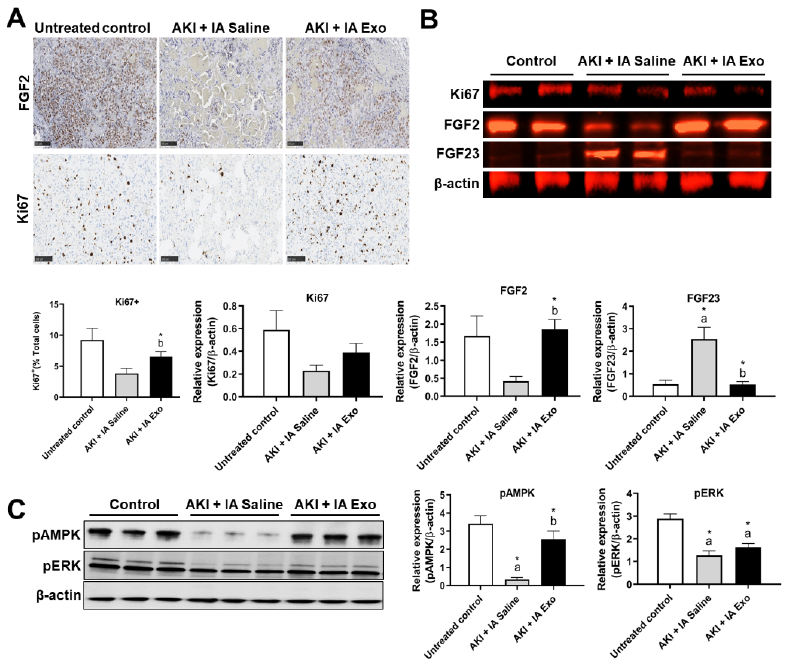
Figure 4. Proliferation and regeneration markers. ( A ) Immunohistochemistry (IHC) of FGF2 and Ki67 in kidney tissue, and quantification of Ki67+ cells. ( B ) Western blot and quantification of Ki67, FGF2, FGF23, and β -actin from kidney lysate. ( C ) Western blot and quantification of pAMPK, pERK, and β -actin from kidney lysate. Measurements were taken at day 12. Each group has n = 3 pooled mice. Significant difference a p < 0.05: relative to untreated control group; b p < 0.05: relative to AKI + IA saline group.